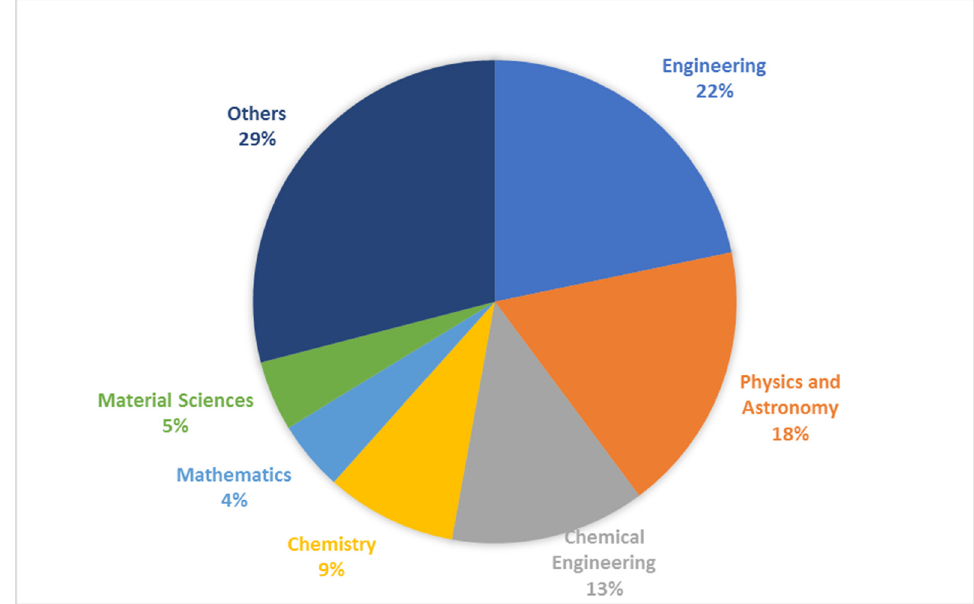
Figure 4. Publications on nanofluids using cavities in different disciplines.